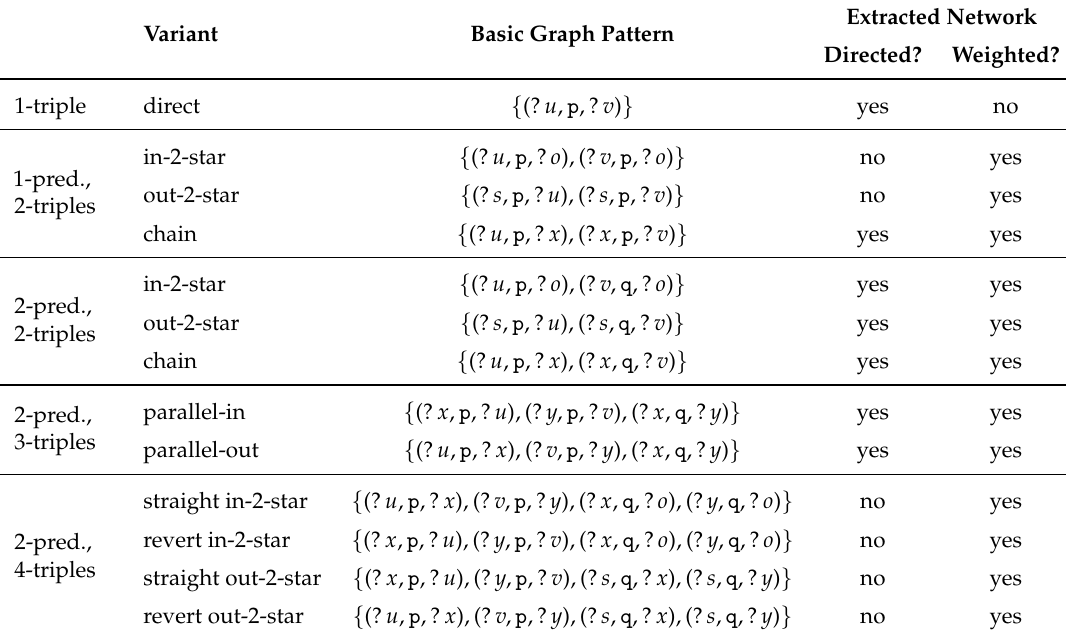
Table 2. Summary of extraction techniques for complete